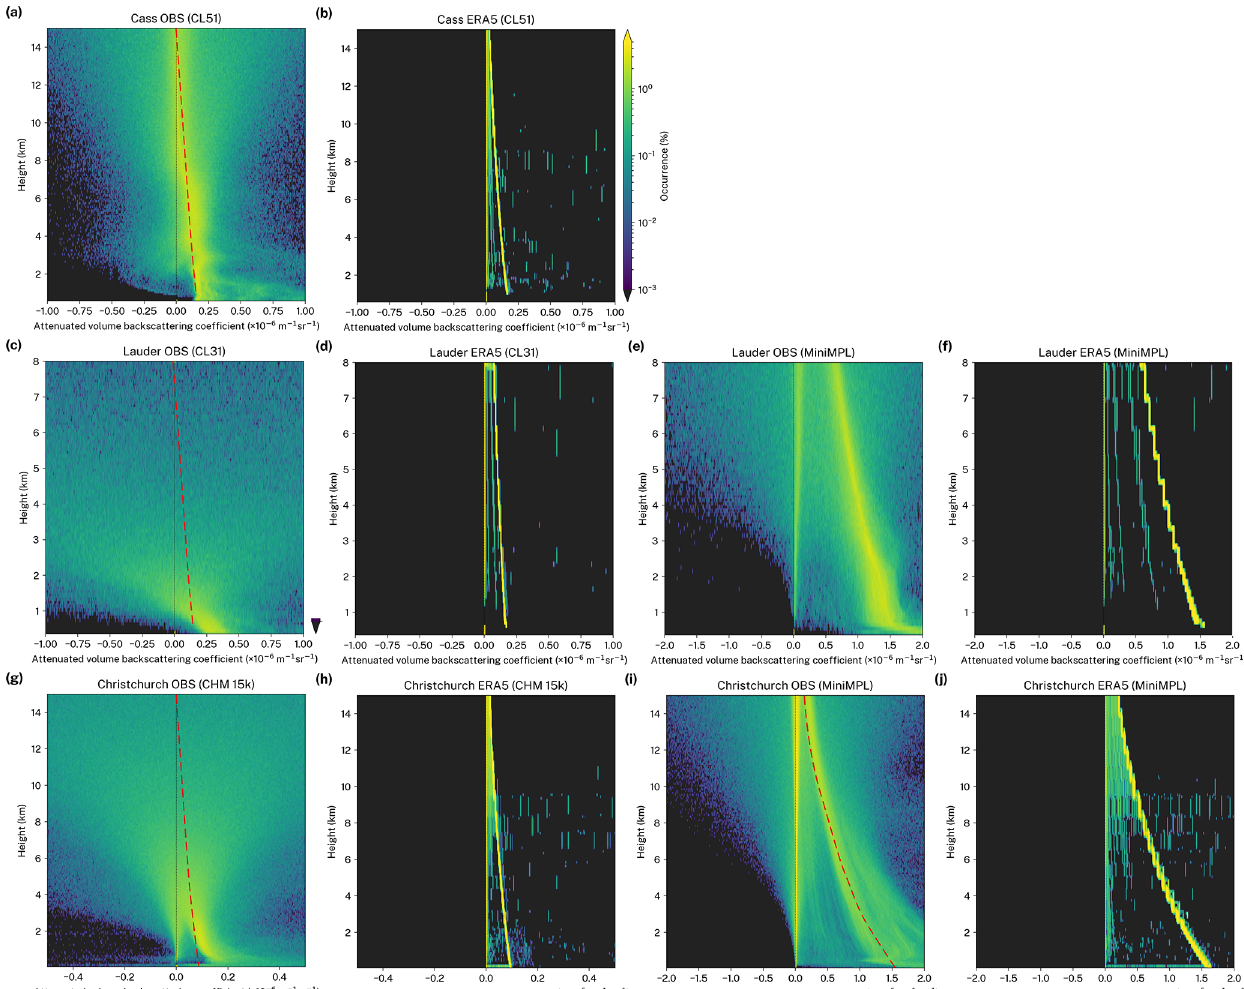
Figure 7. Attenuated volume backscattering coefficient histograms as a function of height observed and simulated at three different sites for the case studies calculated from all profiles. The plots show the distribution of the attenuated volume backscattering coefficient for values which are on the scale of noise, molecular and aerosol backscattering ([ − 0 . 5, 0.5] for CHM 15k, [ − 1, 1] for CL31 and CL51 and [ − 2, 2] × 10 − 6 m − 1 sr − 1 for MiniMPL). The simulated attenuated volume backscattering coefficient is based on the ERA5 atmospheric fields. Backscattering caused by molecular backscattering (the main “streak”), noise when the signal is fully attenuated by cloud (the zero-centred “streak”) and the range-dependent noise (the zero-centred “cone”) are also visible in the plots. The molecular backscattering is marked by a red dashed line on the observed attenuated volume backscattering coefficient plots, the shape of which is taken from the simulated molecular attenuated volume backscattering coefficient for the corresponding instrument and